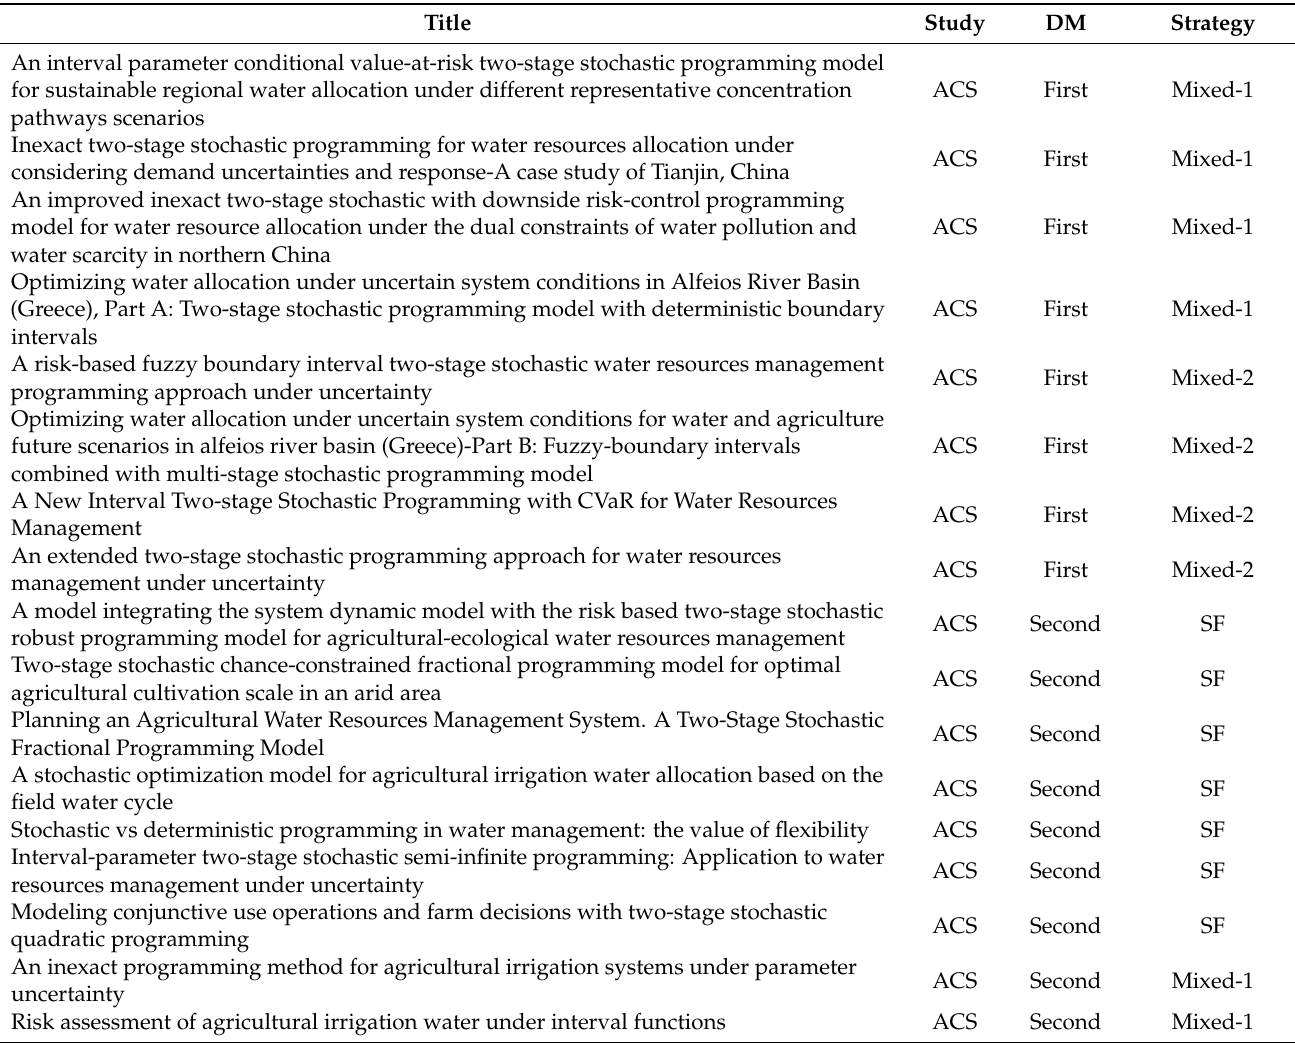
Table A1. Summary of retrieved